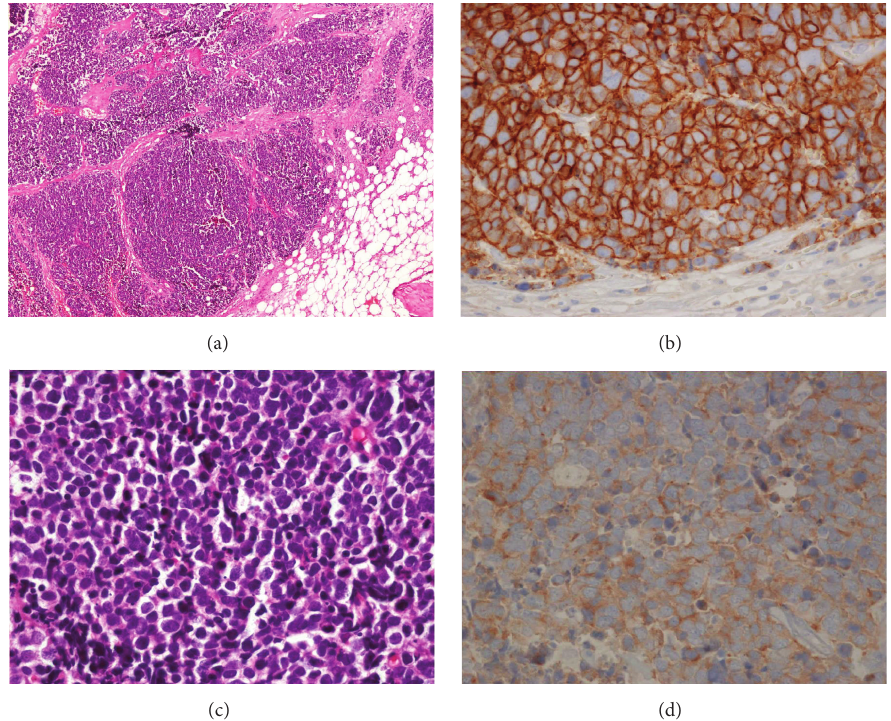
Figure 6: Photomicrographs showing diffuse infiltration of small anaplastic cells ((a) H&E, × 40; (b) H&E, × 400) and immunohistochemical reactivity of tumor cells for CD56 ((c) × 400) and synaptophysin ((d) ×